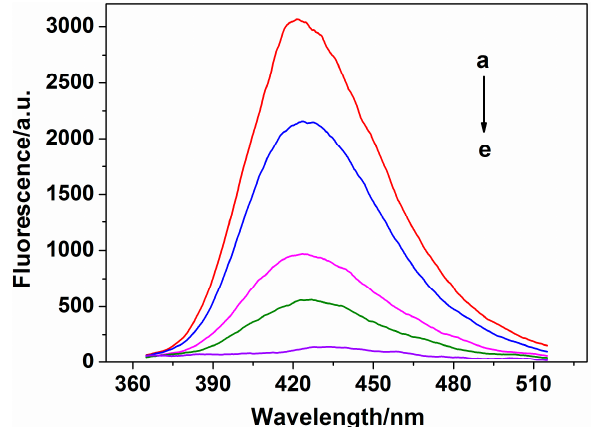
Figure 4. The effect of PtNPs on the formation of hydroxyl radicals in the H 2 O 2 /TA system. Samples were a mixture of 0.25 mM TA, 10 mM H 2 O 2 , and various concentrations of PtNPs (a) 0, (b) 5, (c) 12.5, (d) 25 and (e) 125 µg/L.